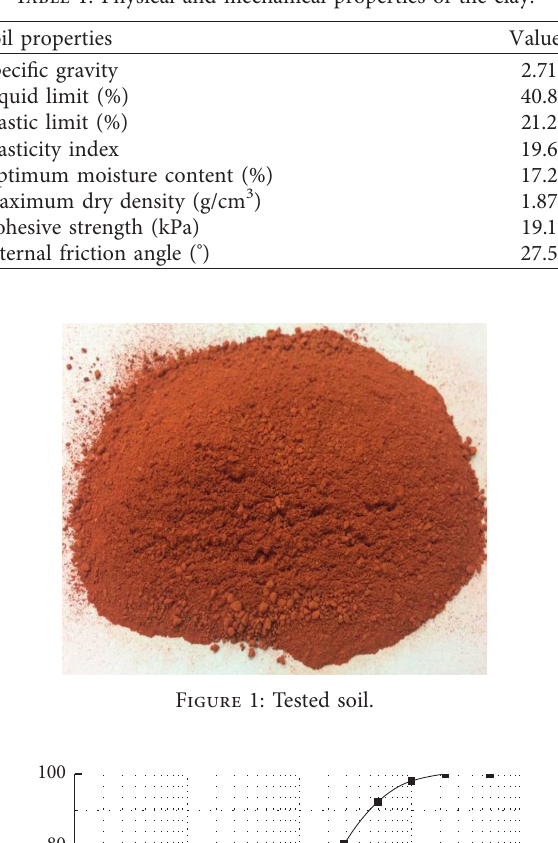
Table 1: Physical and mechanical properties of the clay.